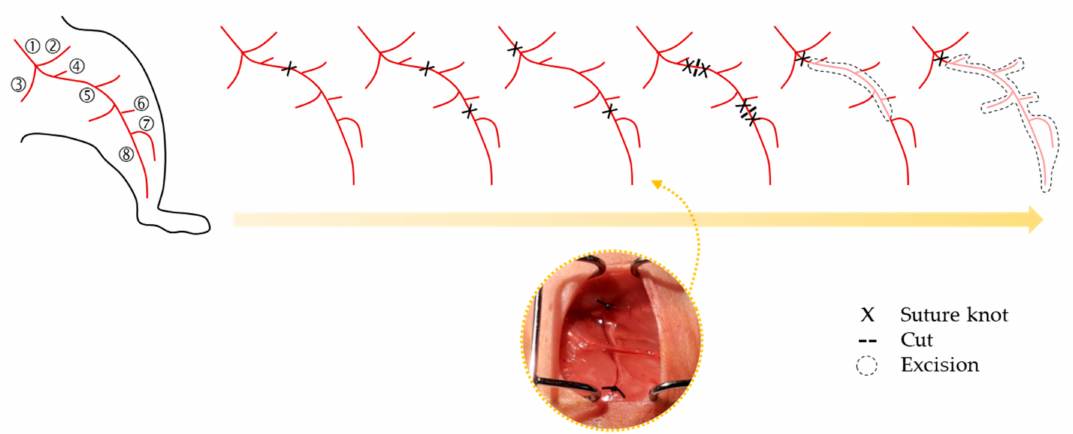
Figure 2. Schematic representation of femoral artery ligation (FAL) strategies usually applied to create PAD/CLI models, from the lowest (left) to the highest (right) severity models of the disease. A representative image of the FAL strategy followed in our research group is also shown [41,47]. Legend: 1 (cid:13) Iliac artery, 2 (cid:13) Iliacofemoral artery, 3 (cid:13) Internal iliac artery, 4 (cid:13) Pudendoepigastric trunk, 5 (cid:13) Femoral artery and its branches (lateral circumflex and proximal caudal), 6 (cid:13) Superficial caudal epigastric artery, 7 (cid:13) Popliteal artery, and 8 (cid:13) Saphenous artery. Arterial anatomy information was based on Kochi et al.